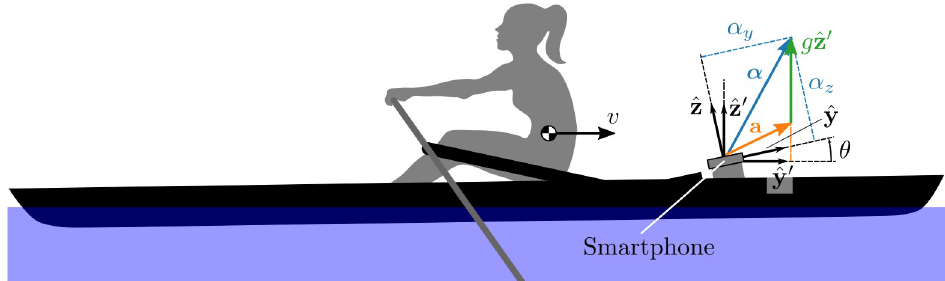
Fig 2. Diagram of a rowing boat under speed with an imperfectly aligned bow-mounted smartphone. The smartphone coordinate system ^ y ; ^ z is oriented relative to the horizontal coordinate system ^ y 0 ; ^ z 0 by a varying pitch angle θ . The accelerometer-reported acceleration α differs from the actual ^ y 0 component because it includes a gravitational component. The actual acceleration a of the phone is then a ¼ α (cid:0) g ^ z 0 . We desire the magnitude of the acceleration a projected onto the horizontal plane but we do not know θ at any given time. As described in the “smartphone acceleration” section, the sensed ^ y acceleration differs from the true ^ y 0 acceleration by a moderate intrinsic bias and a larger term gθ which accounts for the projection of the gravity vector on the pitched ^ y